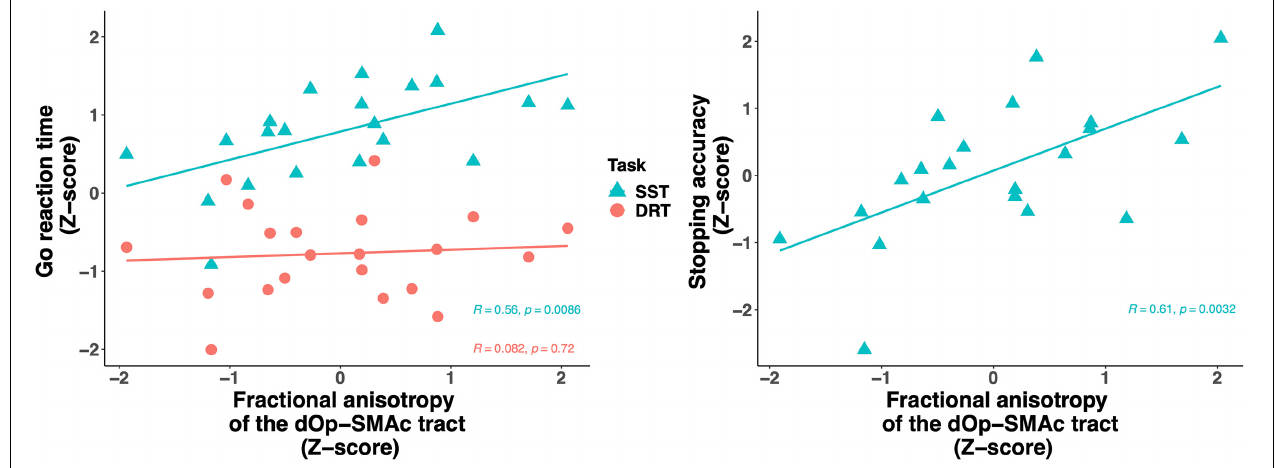
FIGURE 6 | Scatter plot of the fractional anisotropy of the dOp-SMAc tract predicting go reaction time in the stop signal task and the delayed response task (left) and stopping accuracy (right). All variables were z-scored based on the raw values. Go reaction time was scaled across the delayed response task and the stop signal task. dOp, dorsal pars opercularis; SMAc, supplementary motor area